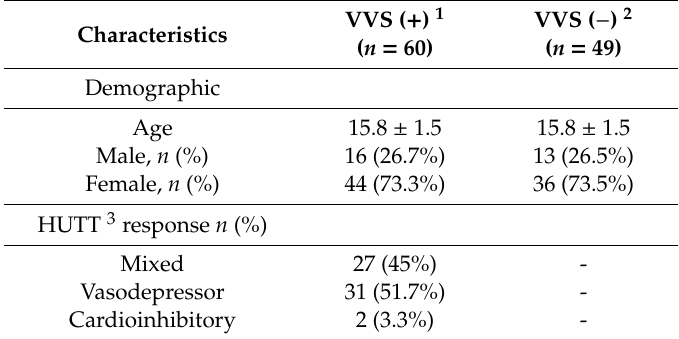
Table 2. Comparison of the characteristics of children with vasovagal syncope (VVS) between the group with positive ( + ) and negative ( − ) head-up tilt table test (HUTT) results.